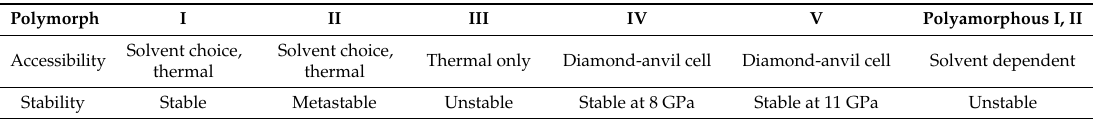
Table 1. Summary of paracetamol polymorphs reported so